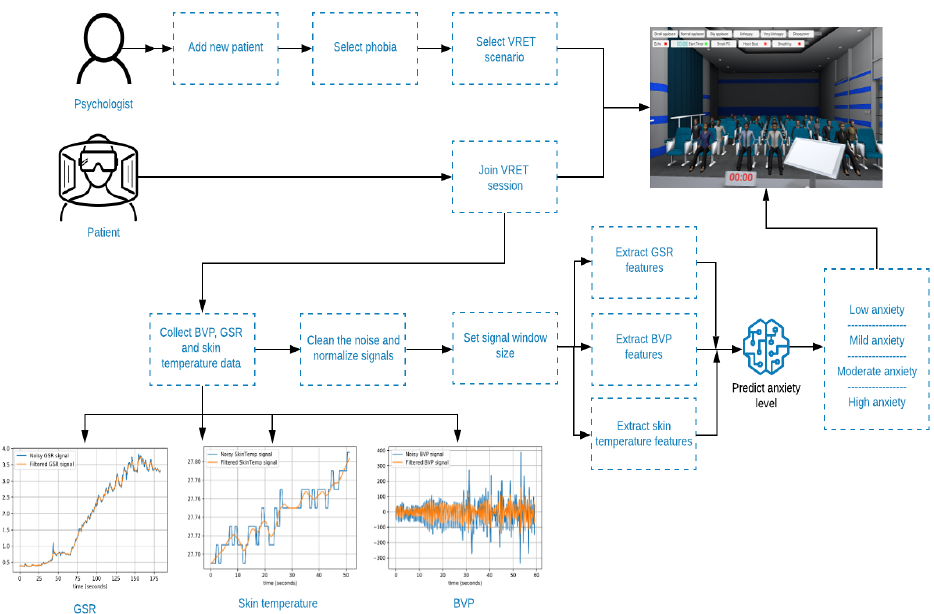
Figure 2. VRET system with anxiety level prediction using physiological